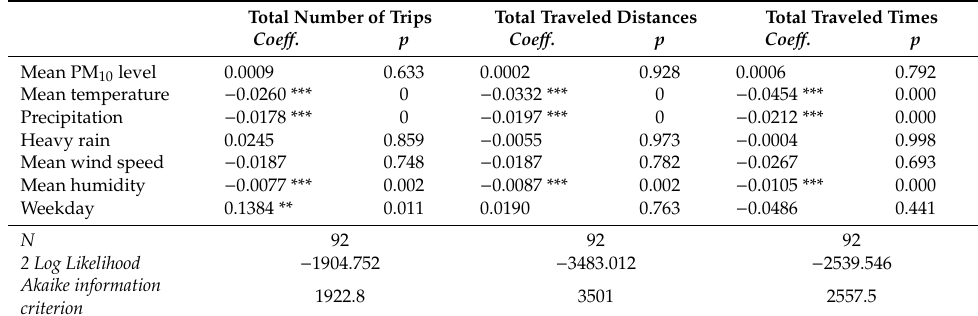
Table 7. Estimation results for bike sharing use using PM 10 level data in summer.